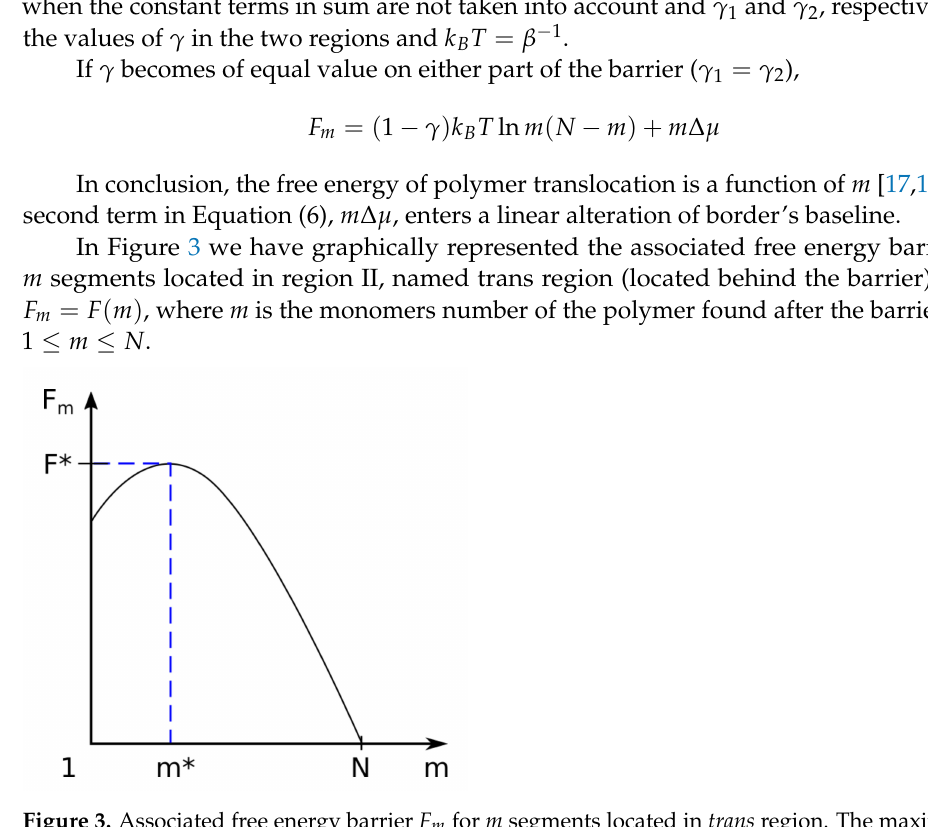
Figure 3. Associated free energy barrier F m for m segments located in trans region. The maximum of the function is the value of the function for m = m* and is denoted by F* = F ( m*